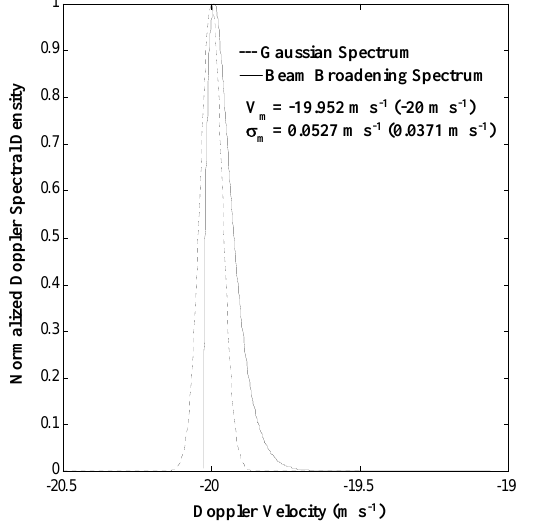
Fig. 7. Estimation error in the vertical wind velocity calculated from the first moment method of the beam broadening spectrum caused by vertical and horizontal winds.